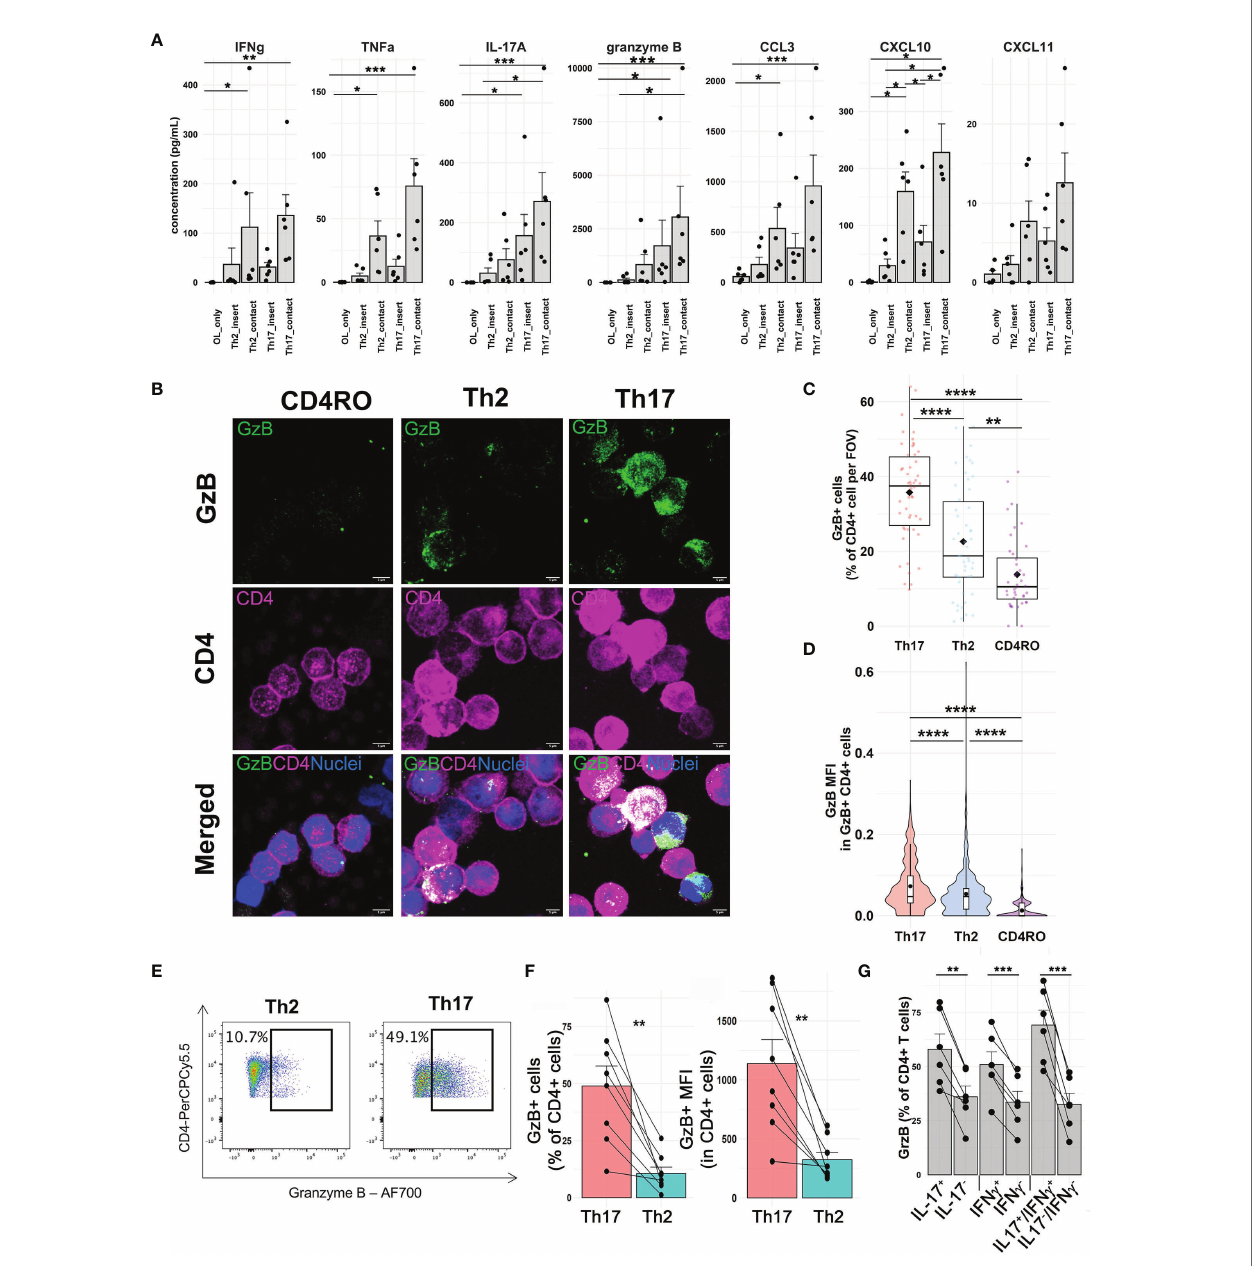
FIGURE 3 | Secretion of pro-in fl ammatory cytokines, chemokines, and granzyme B upon direct contact between Th17-polarized cells and human OLs. (A) Concentration of analytes measured by a Luminex assay in supernatants from human polarized Th cells in direct contact or not with oligodendrocytes (OLs). Each dot represents one donor and OL prep, n = 6 different OL preps, and 6 T cell donors. Friedman test with Dunn ’ s method or one way ANOVA with Tukey ’ s post hoc test according to distribution for each analyte. (B) Representative confocal images (immuno fl uorescence, scale bar = 5 µm) of granzyme B expression (GzB, green) by CD4 + memory T cells ex vivo or after Th2 polarization versus Th17 polarization (magenta) and (C) quanti fi cation of the percentage of CD4 + GrzB + - positive cells per fi eld of view (FOV) and (D) the median fl uorescence intensity (MFI) per cell in CD4 + GzB + cells. Wilcoxon rank test, n = 5 donors, diamond = mean. (E) Representative fl ow cytometry pseudocolor dot plots of GzB staining in polarized T cells and (F) quanti fi cation of percentage of CD4 + cells expressing GzB and median fl uorescence intensity (MFI) in CD4 + T cells after 4 h PMA-ionomycin stimulation, paired t-test, n = 8 donors. (G) Percentage of Th17-polarized cells expressing granzyme B gating on IL-17 + , IFN g + , or double-positive cells compared to their negative counterpart, paired t-test, n = 6 donors. *p < 0.05; **p < 0.01; ***p < 0.001; ****p <